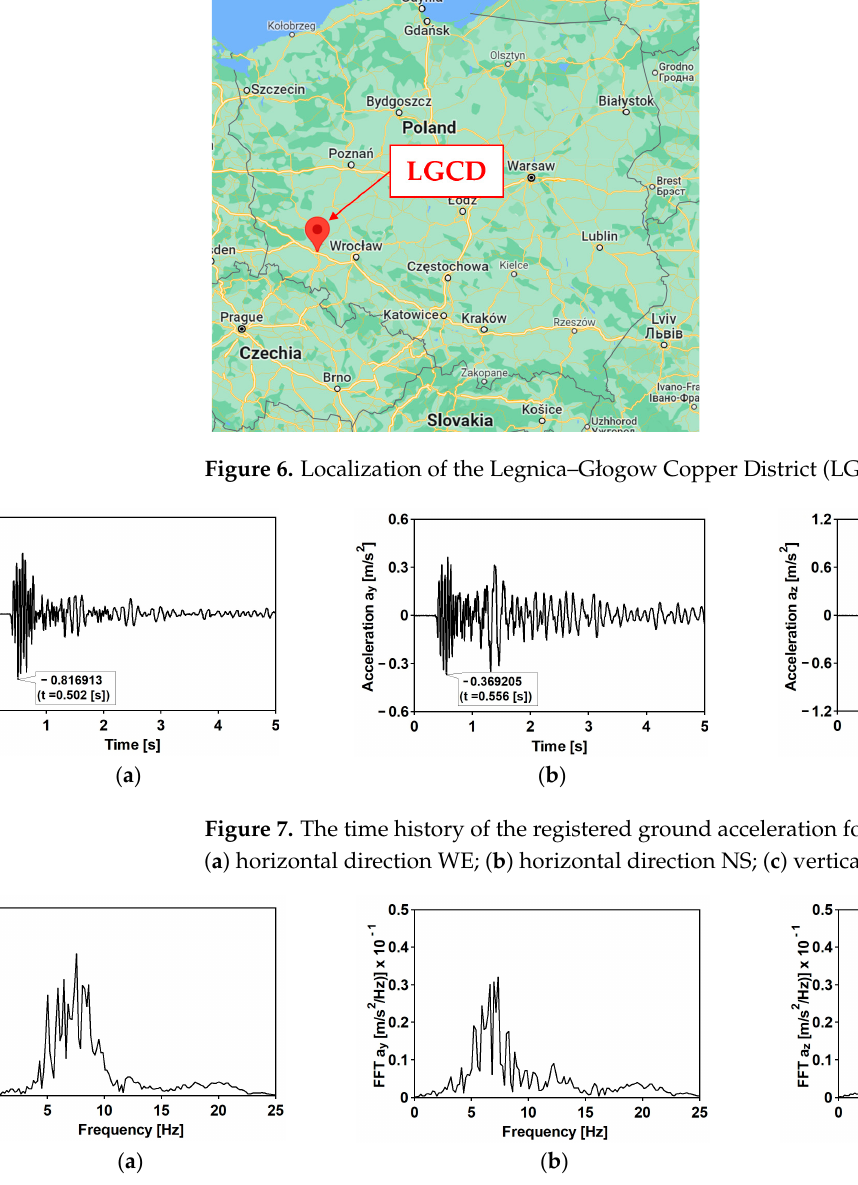
Figure 6. Localization of the Legnica–G ł ogow Copper District (LGCD) on Polands’ map.